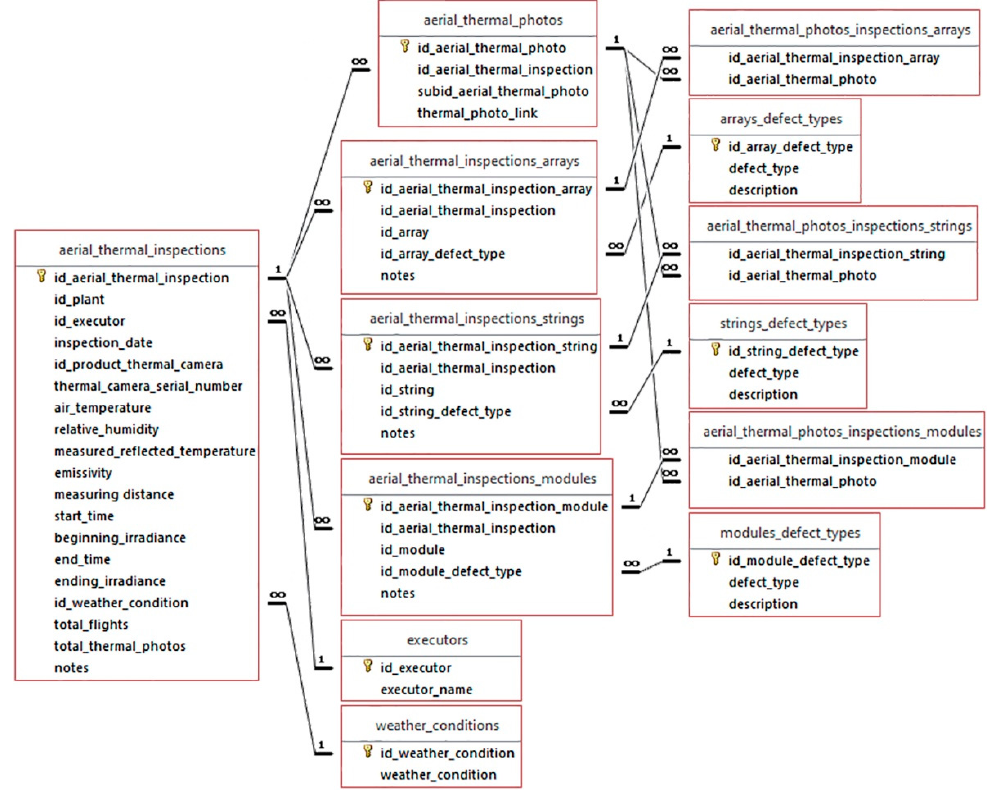
Figure 10. The aerial thermal inspections group of the conceptual model of the relational database.